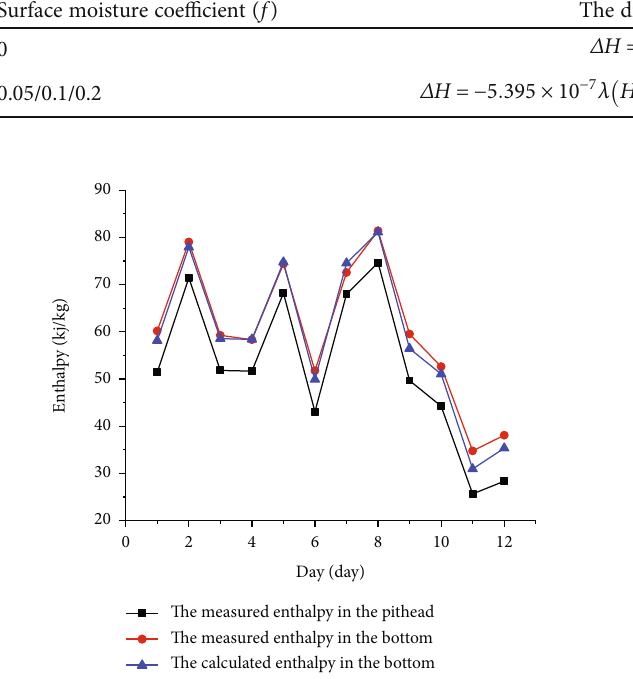
Figure 12: Comparison between the enthalpy of the calculated and measured in literature [24] at the shaft